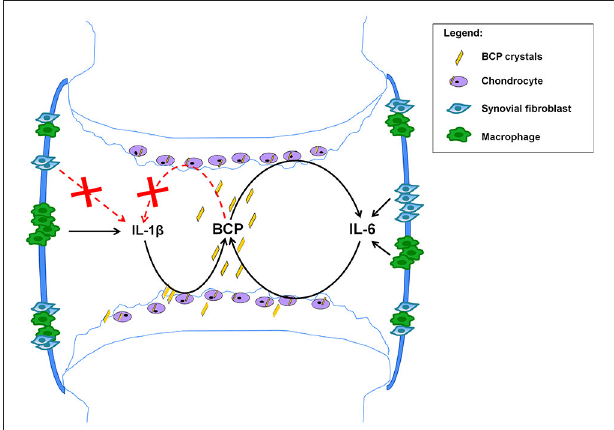
FIGURE 5 | Proposed mechanism based on the obtained results. BCP crystals found in 100% of OA patients at the moment of joint replacement (Ea et al., 2011), can activate NLRP3 inflammasome in macrophages leading to IL-1 β secretion (Pazar et al., 2011), but this process does not occur in chondrocytes and synovial fibroblasts ( Kolly et al., 2010; Jin et al., 2011). In addition BCP crystals induce IL-6 in macrophages, fibroblasts and chondrocytes. In these latter cells, BCP crystals induce IL-6, which in turn induce mineralization, thus creating a vicious circle and a chronification of the disease. Strategies interrupting this vicious circle could ameliorate this degenerative